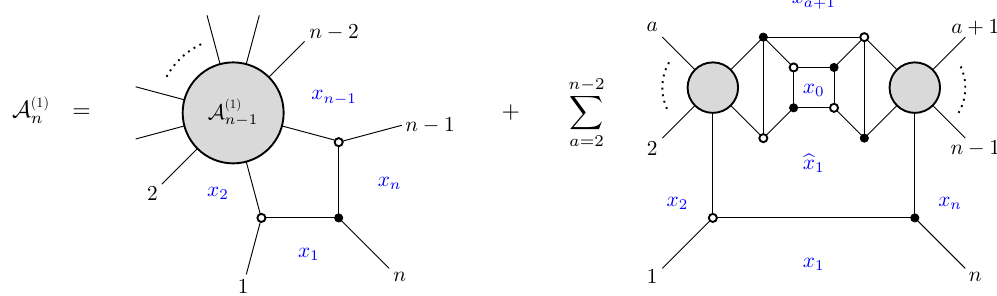
Figure 4 . On-shell diagram recursion relation for one-loop MHV amplitudes, where the (cid:12)rst term corresponds to tree-level factorisation, and the second term corresponds to a forward